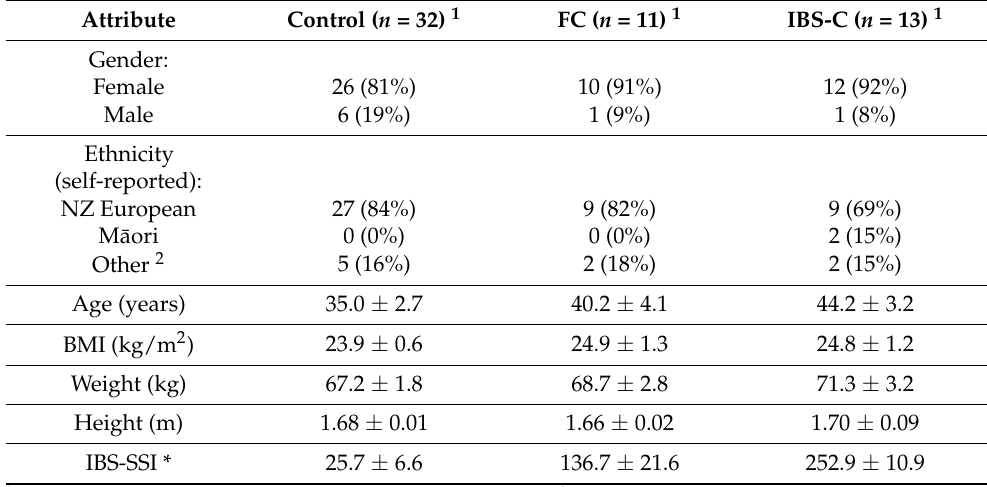
Table 2. Baseline subject characteristics and IBS Symptom Severity Index (IBS-SSI).